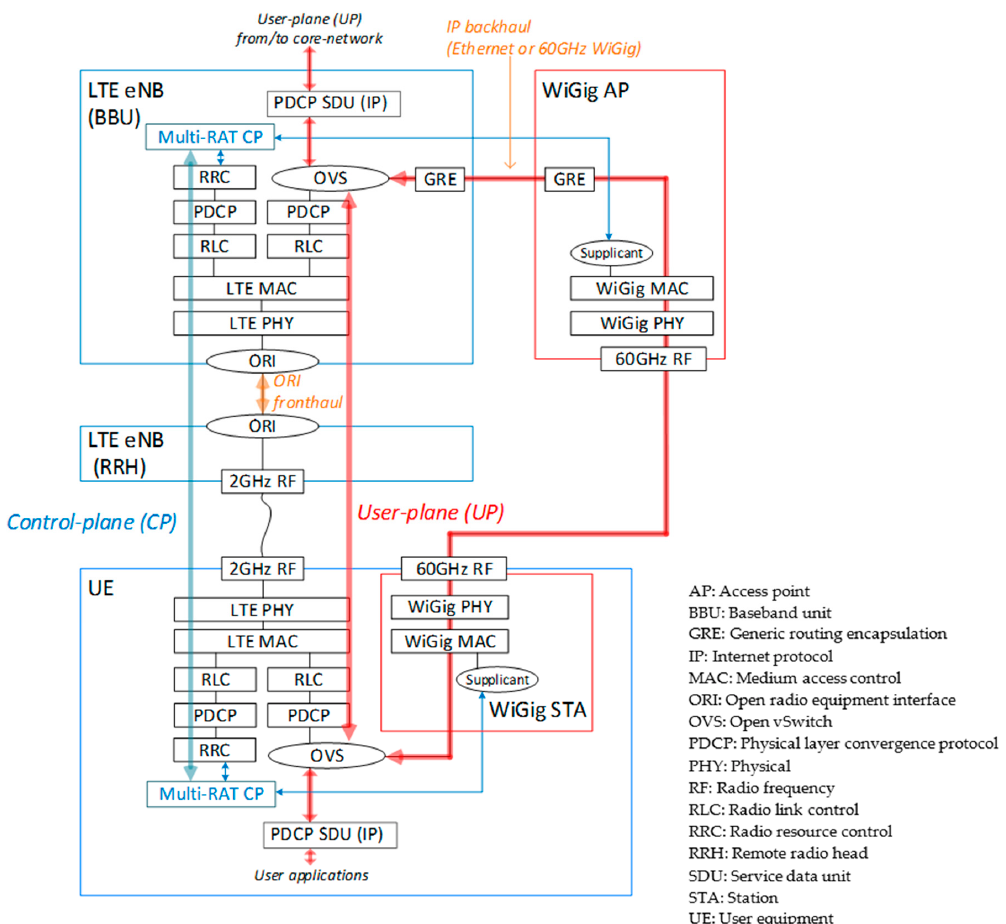
Figure 13. Protocol stack of LTE-WiGig-integrated HetNet PoC.